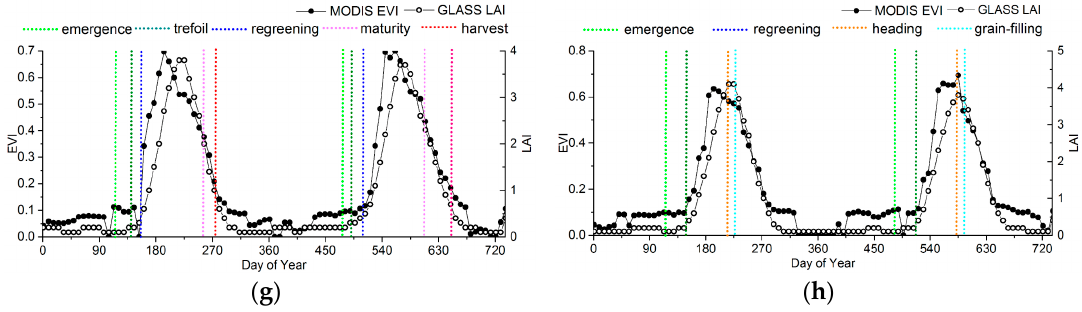
Figure 9. Comparison between the LAI and the EVI time series for different vegetation types based on the ground observations. ( a ) HS (ENF); ( b ) DHS (EBF); ( c ) BJF (DNF); ( d ) CBS (DBF); ( e ) SPT (shrub); ( f ) NM (grass); ( g ) SY (rice); ( h ) JT (rice).